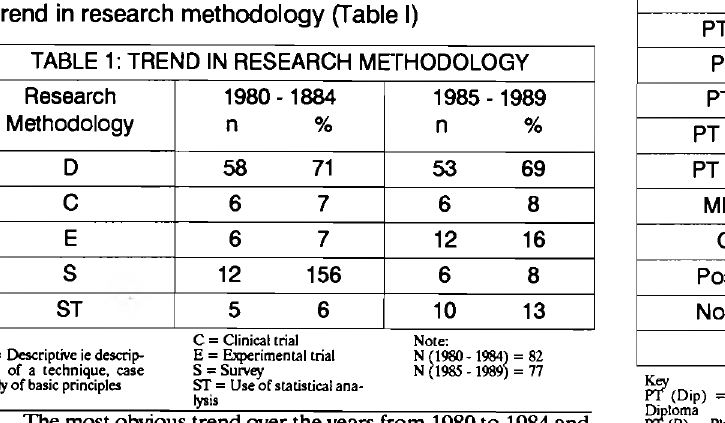
TABLE 1: TREND IN RESEARCH MERHODOLOGY